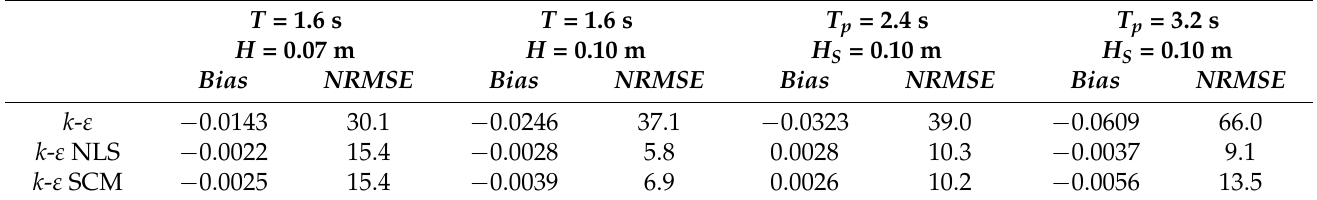
Figure 20. Sketch of the computational domain for the rubble mound breakwater case.